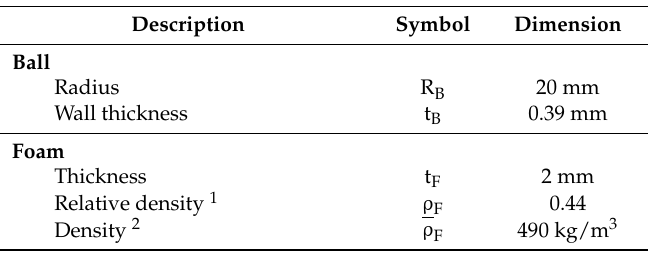
Table 1. Dimensions of the ball and polymer layers.